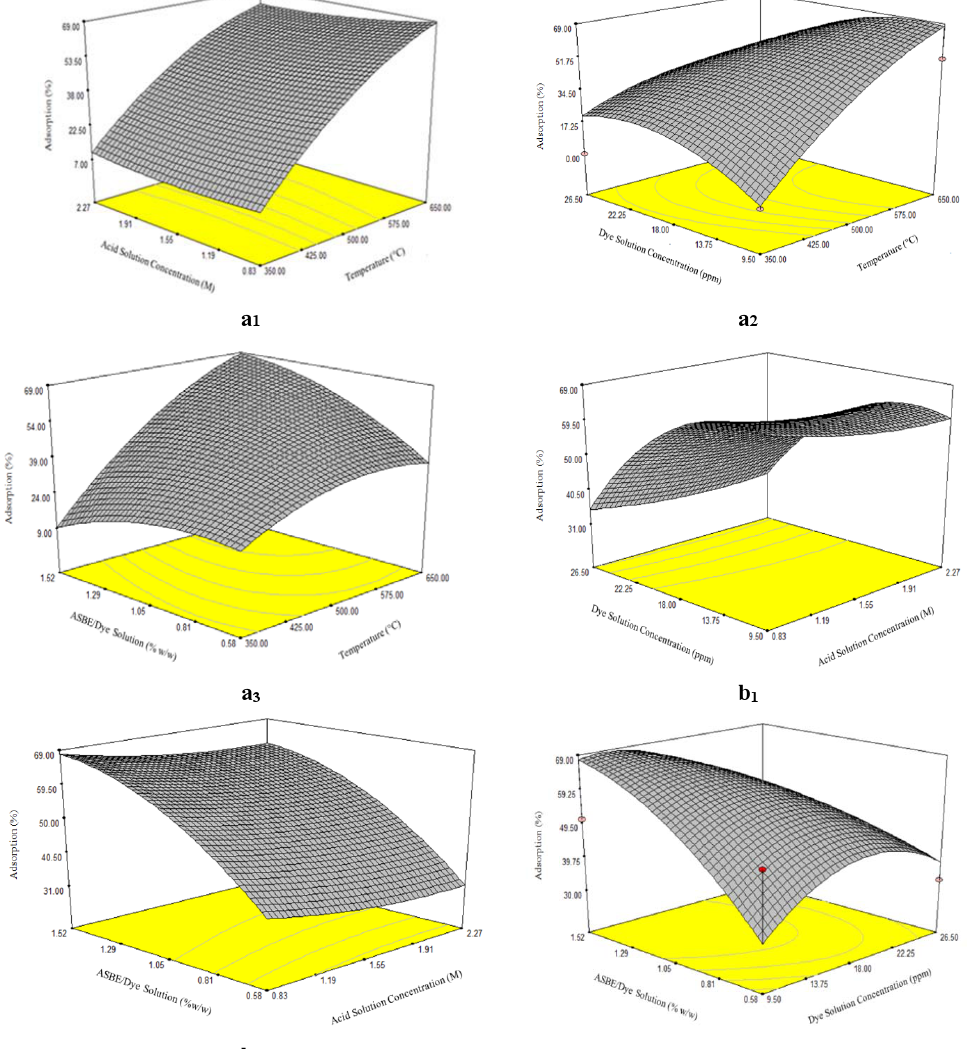
Fig. 6: RSM diagrams of parameters interactions on dye adsorption utilizing ASBE process, layers surfaces and interlayer spaces for dye solution adsorption are available. Higher Temperature leads to destruction of clay structure, layers surfaces and interlayer spaces loss. Consequently, a considerable reduction in clay adsorption